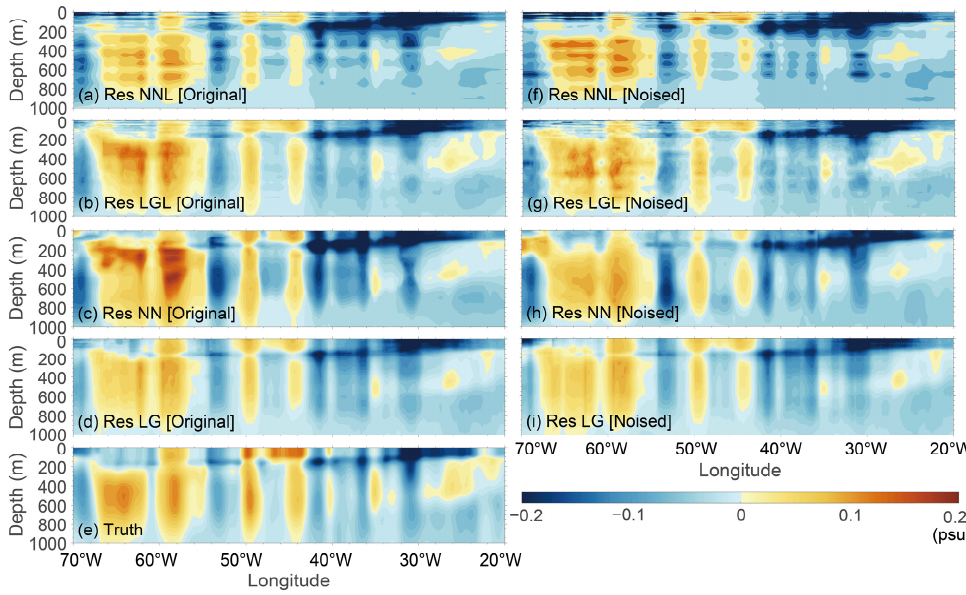
Figure 8. Vertical section along 35.375°N in the Gulf Stream region of the reconstructed data and truth values of the CNRM-CM6-1-HR model. The fields for January 1998 are shown. ( a – d ) Experiments performed with the original synthetic dataset. ( f – i ) Experiments performed with the noised synthetic dataset. ( e ) Truth value of